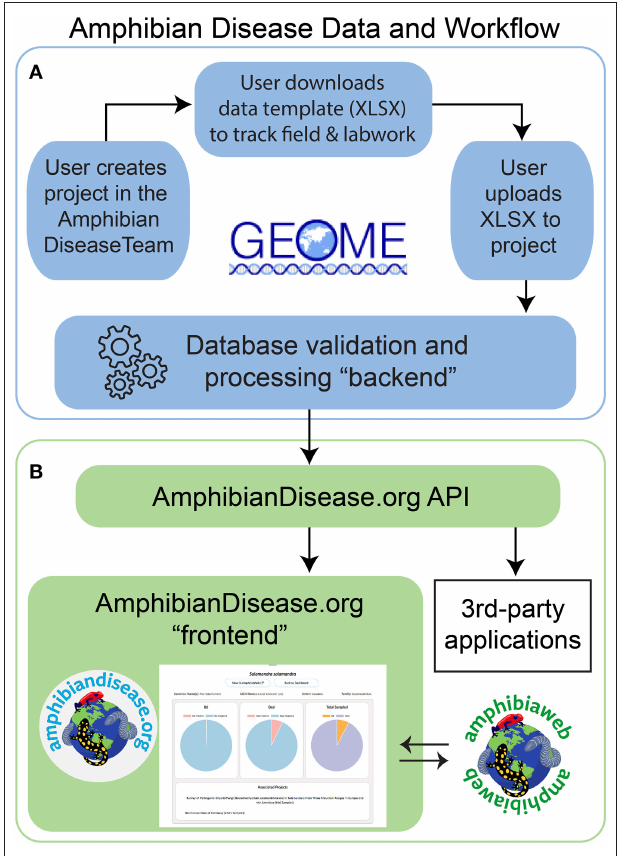
FIGURE 1 | Amphibian Disease Portal data and work flow. (A) Users begin the process of contributing data by creating a project in Geome under the Amphibian Disease Team; user can download a data template for field and laboratory work. Once data gathering is complete, user uploads to the project for processing at Geome, and data are now available via the AmphibianDisease API. (B) The “frontend” includes the website AmphibianDisease.org where aggregated data can be graphed, mapped, queried, and downloaded. The AmphibianDisease API allows data to